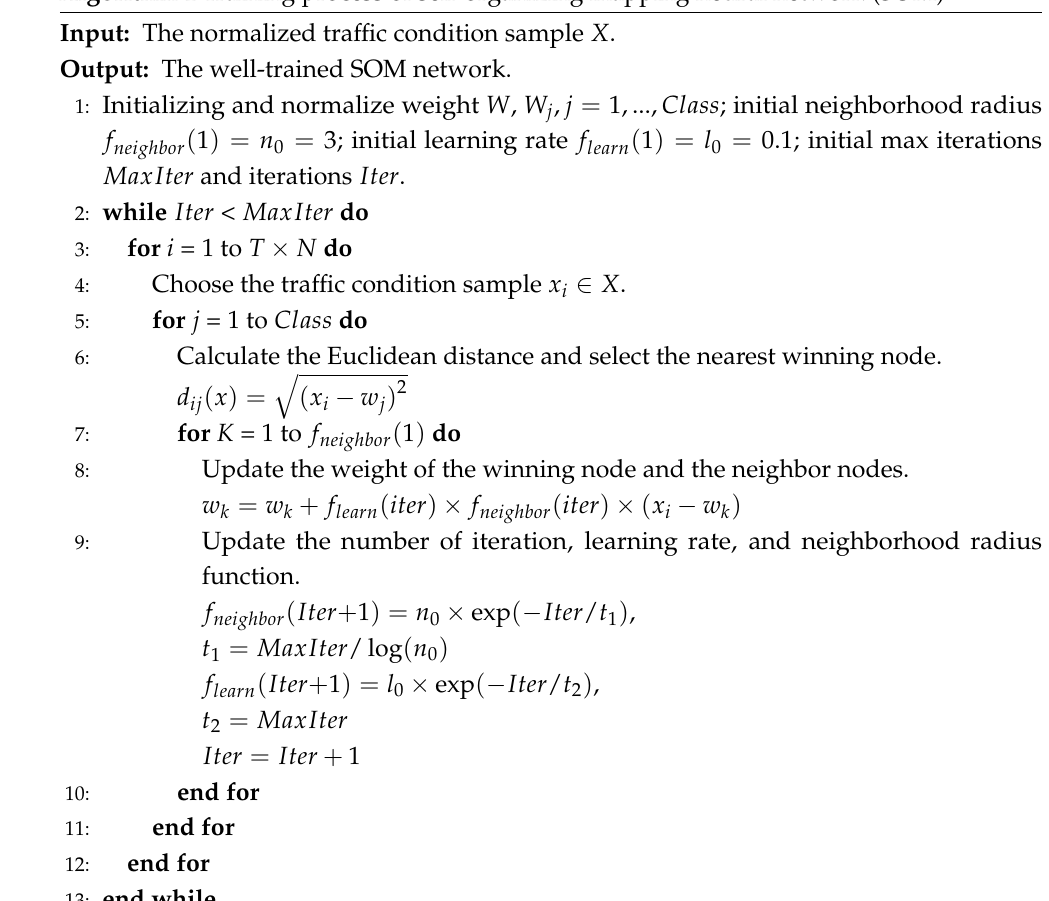
Algorithm 1 Training process of self-organizing mapping neural network